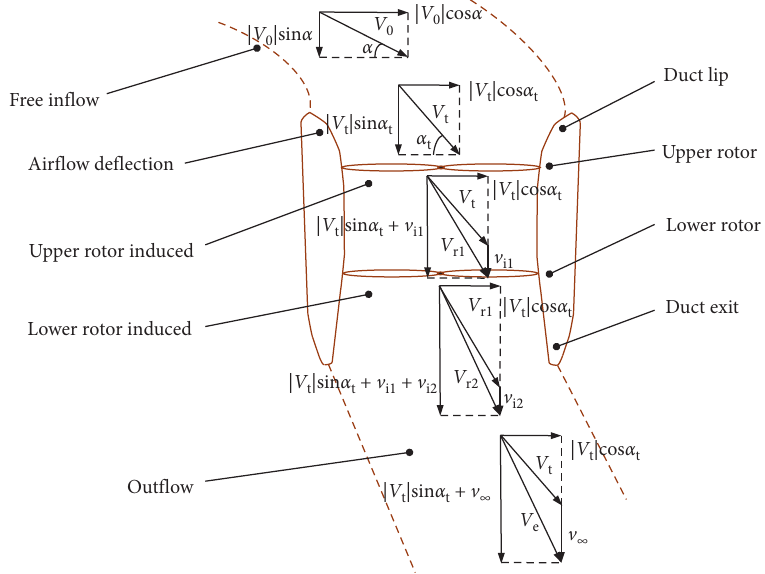
Figure 7: The inflow process